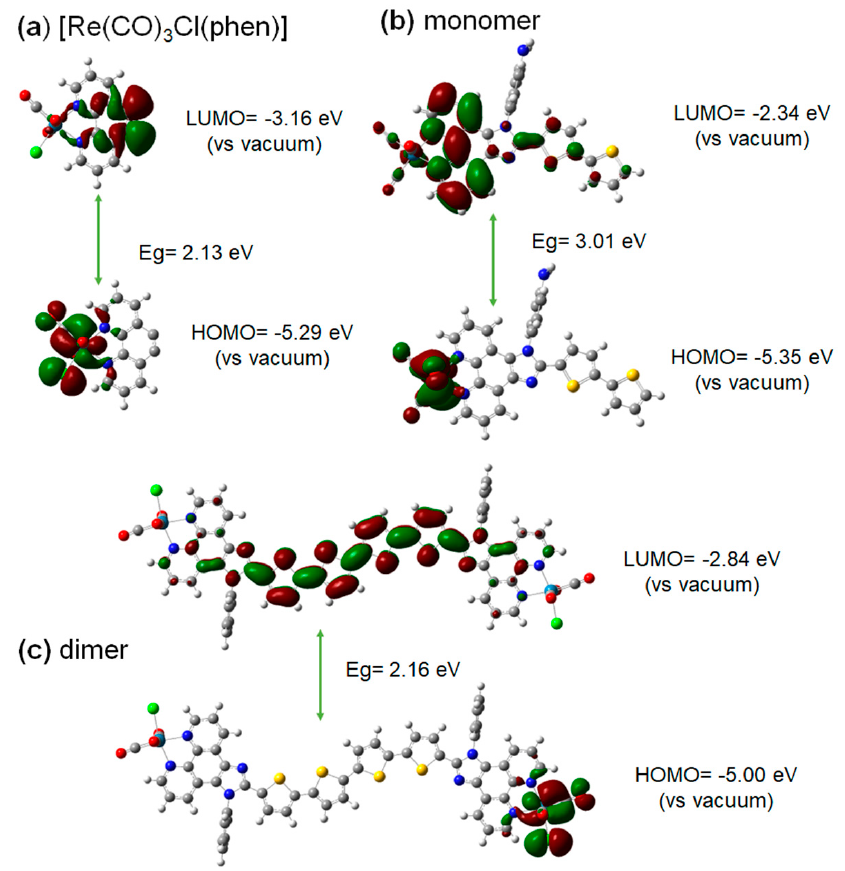
Figure 4. The distribution of frontier molecular orbitals of [Re(CO) 3 Cl(phen)] ( a ), [Re(CO) 3 Cl(L)]- monomer ( b ) and the [Re(CO) 3 Cl(L)]-dimer ( c ).